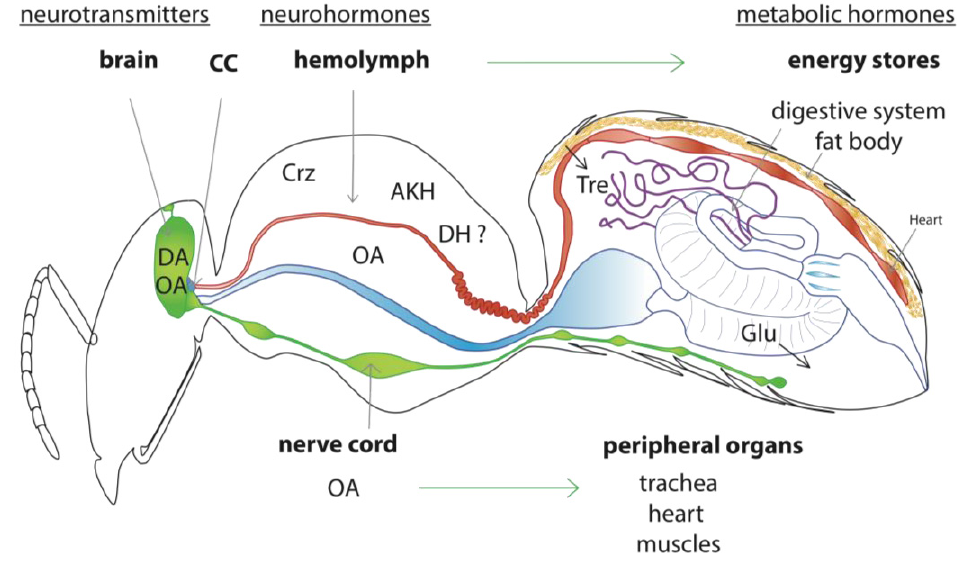
Figure 2. Hypothesized model of the general stress system in the honey bee. The brain biogenic amines (OA) and dopamine (DA), acting as neurotransmitters or neuromodulators, would increase arousal, cognitive processes and sensitivity to various stimuli. Then, neurosecretory cells of the corpora cardiaca (CC), would release metabolically active hormones into the hemolymph. These may include corazonin (Crz), adipokinetic hormone (AKH), and possibly diuretic hormone-I (DH). This cocktail of hormones mobilize energy from the midgut and the fat body (see detail in Figure 3). Activation of the octopaminergic DUM (Dorsal Unpaired Median) neurons of segmental ganglia of the ventral nerve cord would stimulate activity of skeletal and visceral muscle. Metabolic hormones like allatostatinA, tachykinin-related and insulin-related peptides can be released from peripheral neurosecretory cells, where they can modulate gut motility, and may also contribute to regulate the release of Crz, AKH and DH from the